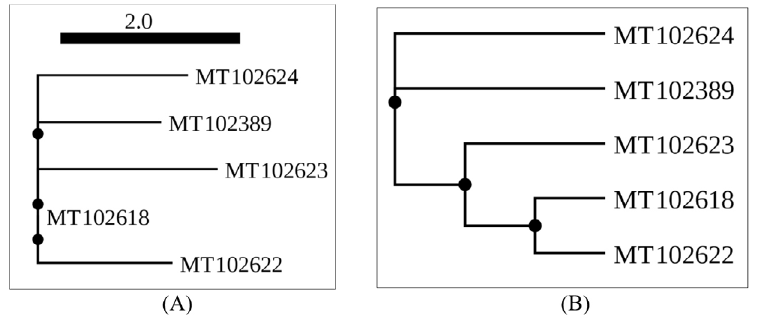
Fig. 10. (A) Phylogram and (B) Dendrogram prepared by using PhyML version: